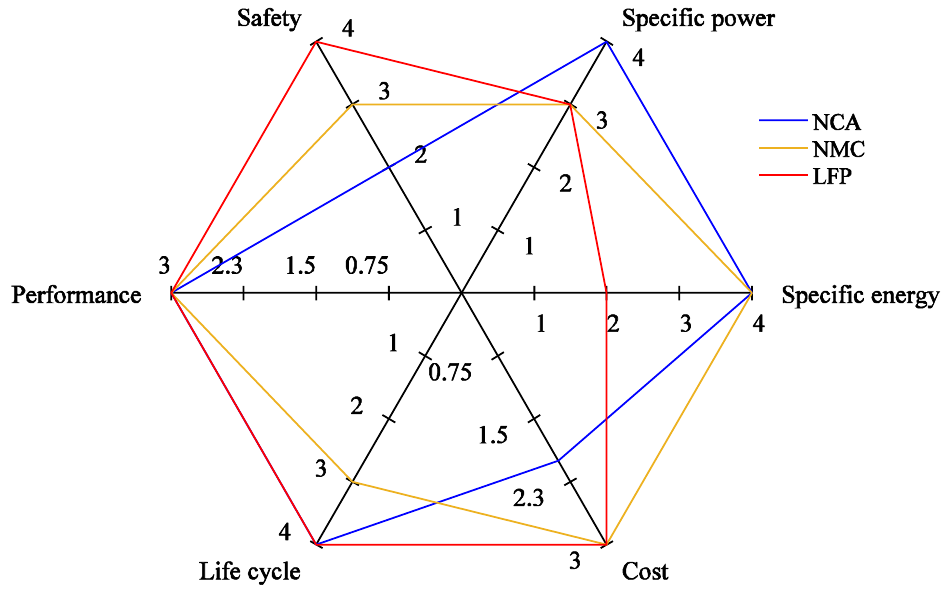
Figure 4. Performance parameters of various battery chemistries.